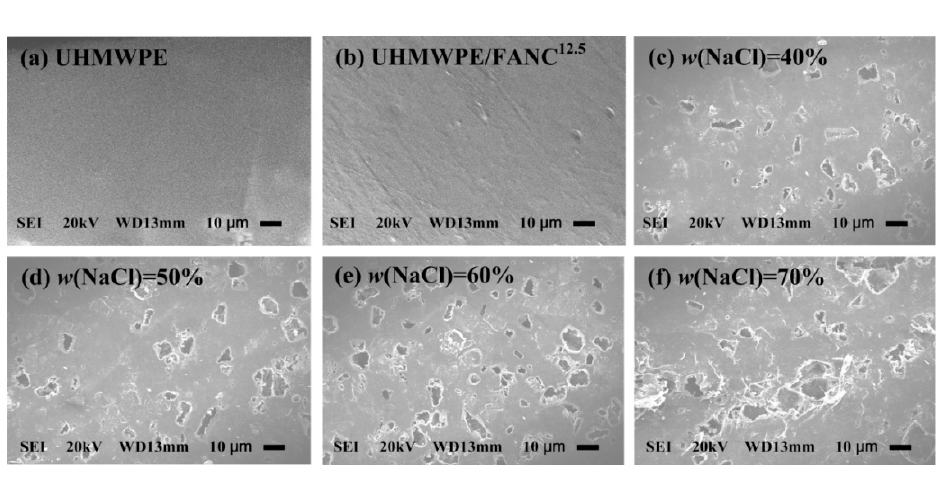
Figure 5. SEM of the surface of UHMWPE, UHMWPE/FANC 12.5 , and porous UHMWPE/FANC 12.5 specimens with 3% weight contents of FANC 12.5 . The magnification is 1500×. ( a ) UHMWPE with no any additives, ( b ) UHMWPE/FANC 12.5 with no NaCl, ( c ) UHMWPE/FANC 12.5 (FANC 12.5 3%, NaCl 40%), ( d ) UHMWPE/FANC 12.5 (FANC 12.5 3%, NaCl 50%), ( e ) UHMWPE/FANC 12.5 (FANC 12.5 3%, NaCl 60%), ( f ) UHMWPE/FANC 12.5 (FANC 12.5 3%, NaCl 70%).